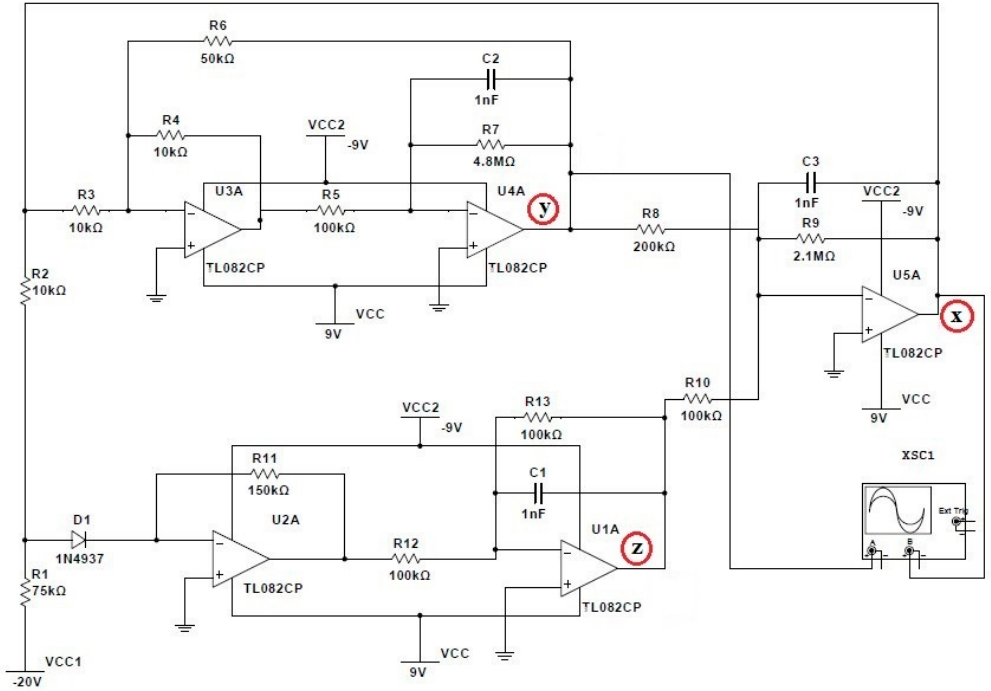
Figure 1. Schematic circuit for the implementation of a Rössler attractor system.